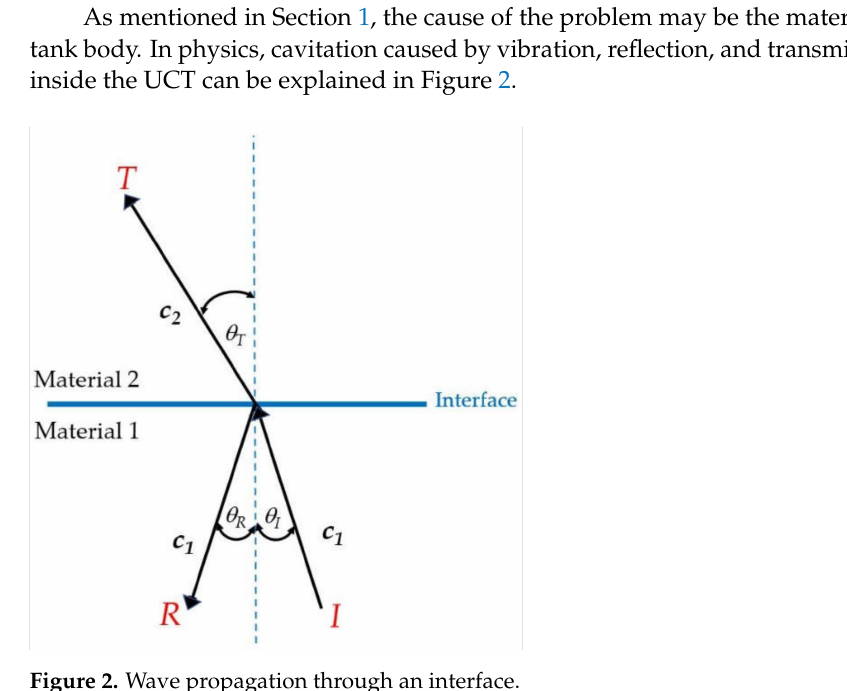
Figure 2. Wave propagation through an